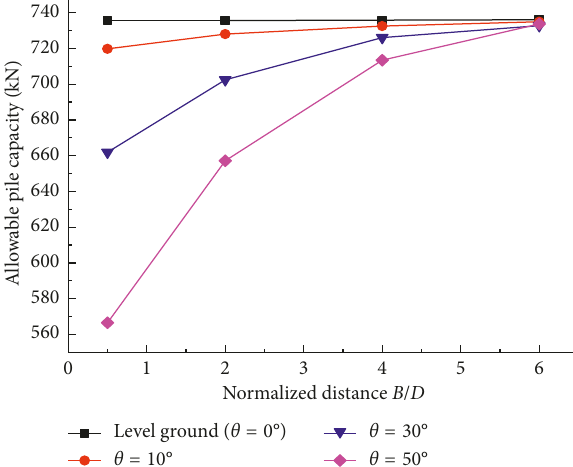
Figure 14: Lateral load-deflection curves for θ normalized distance of pile at pile head.